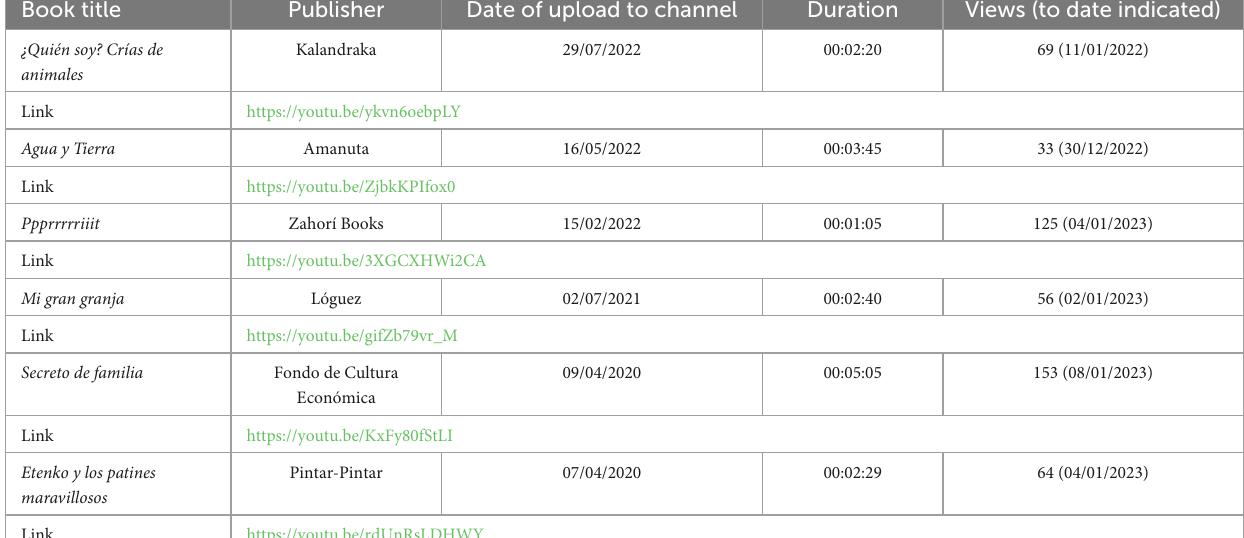
TABLE 10 Examples of virtual epitexts that emphasize the role of the child reader and extend the reception